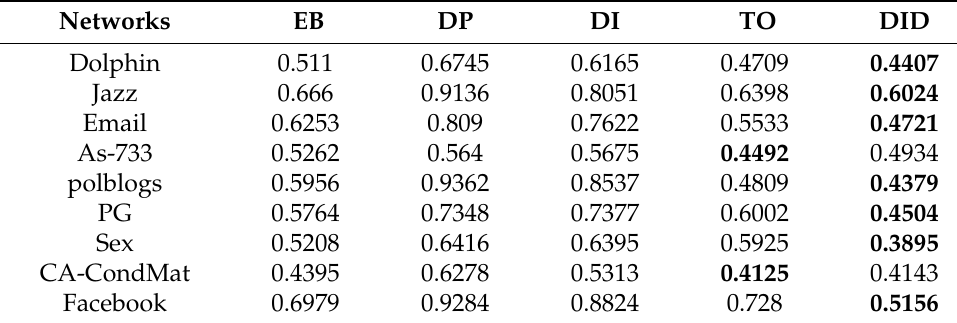
Table 5. The R of DID and classic algorithms in real networks.